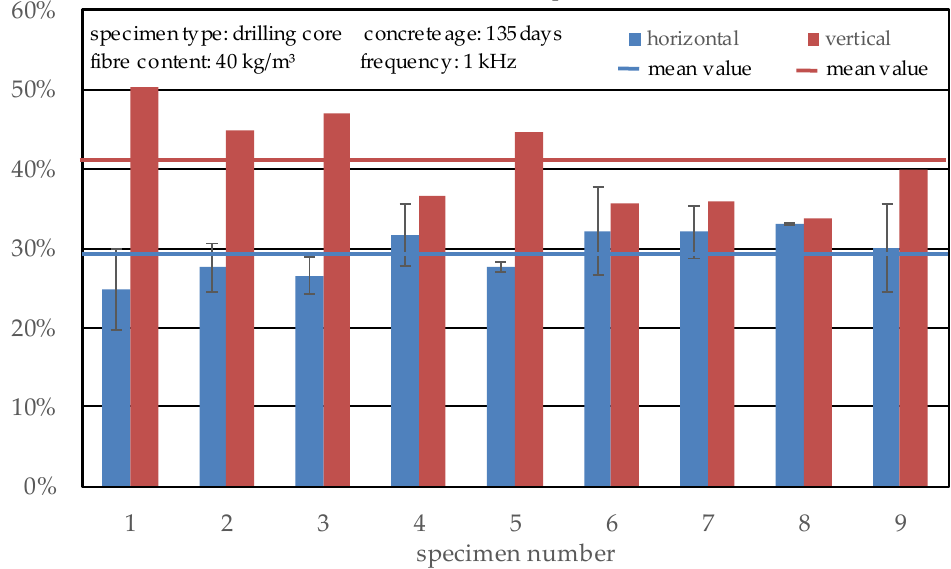
Figure 16. Calculated fibre orientation of the drilling cores with a fibre content of 40 kg/m³.